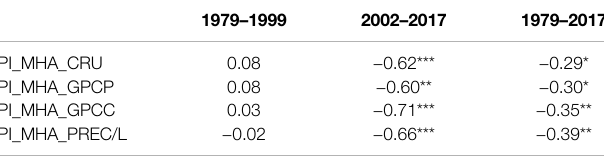
TABLE 1 | The correlation coef fi cients between winter Arctic Oscillation index (AOI) and simultaneous precipitation index over the mid – high latitudes of Asia (40 ° – 56 ° N, 75 ° – 120 ° E) (PI_MHA) in the periods of 1979 – 1999, 2002 – 2017 and 1979 – 2017. The PI_MHA is derived from the four precipitation datasets (CRU,